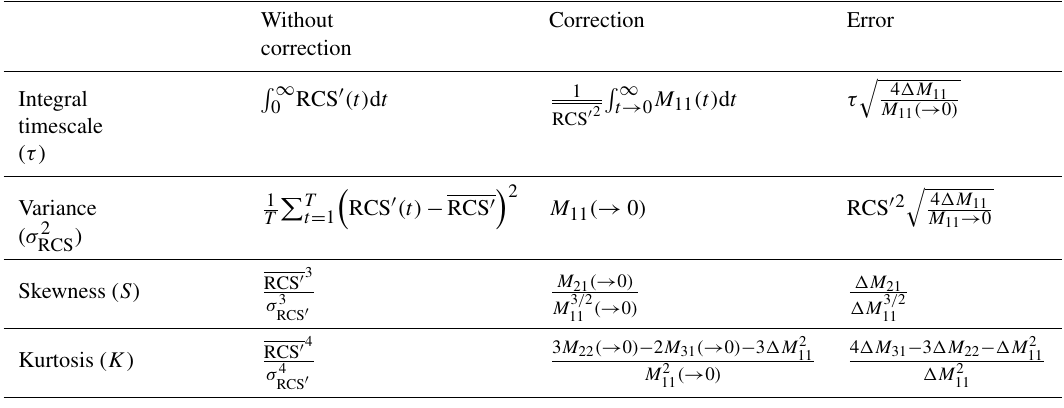
Table 1. Variables applied to statistical analysis of turbulence in the ABL region (Lenschow et al., 2000). The sum of subindex of autoco- variance function M ij represents the order of the analysis.